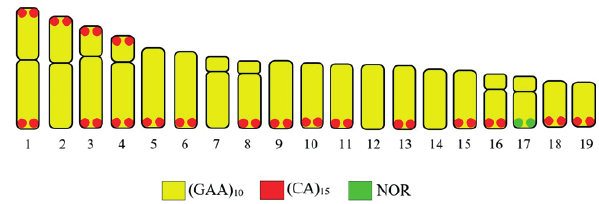
Figure 3. Idiogram represents the microsatellite probes (CAA) 10 , (CA) 15 and Ag-NOR banding on the chromosomes of G. petricolus